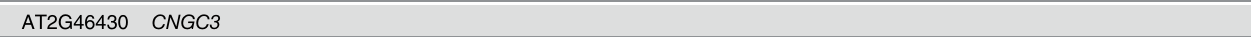
Numbers in parenthesis indicate rank in the other mountain. Asterisks indicate the presence of other genes that are located in the same genomic island. AGI codes in bold indicates genes with nonsynonymous SNPs that were highly differentiated ( G ’ ST > 0.4) between the lowest and highest populations. See S3 Table for the extended